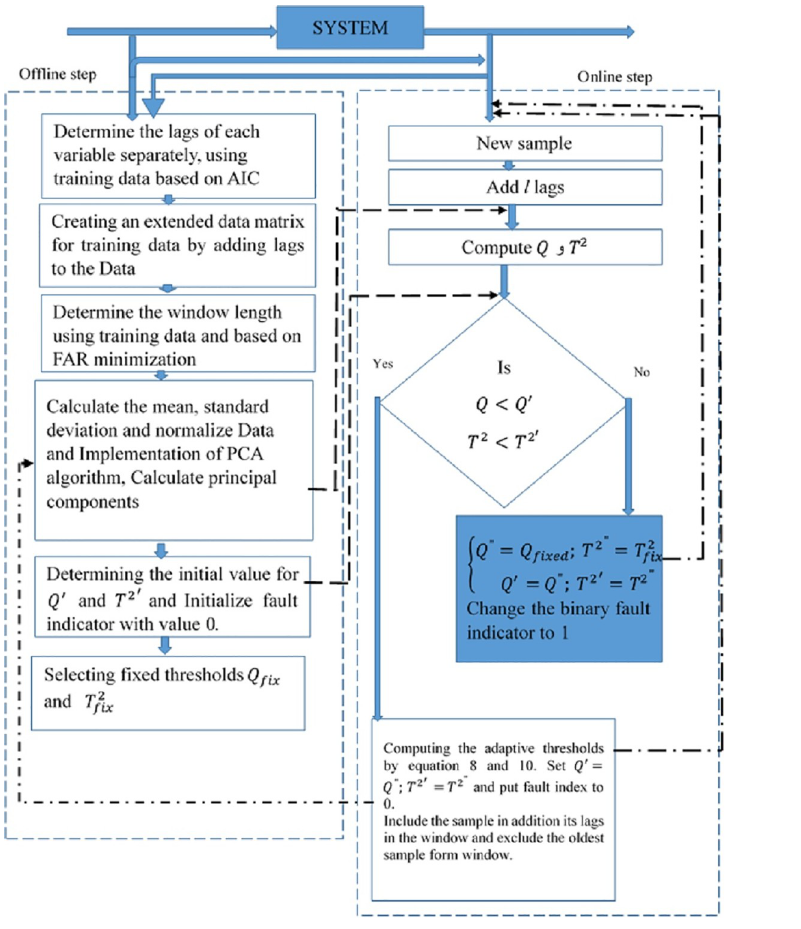
Fig 4. Moving window dynamic PCA